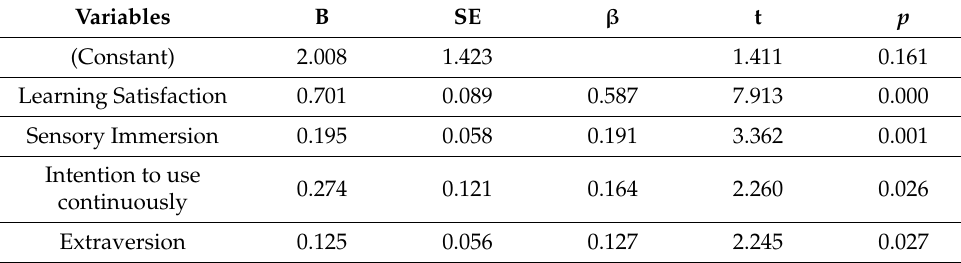
Table 5. Factors Influencing the Learning Effects of Virtual Reality Media.